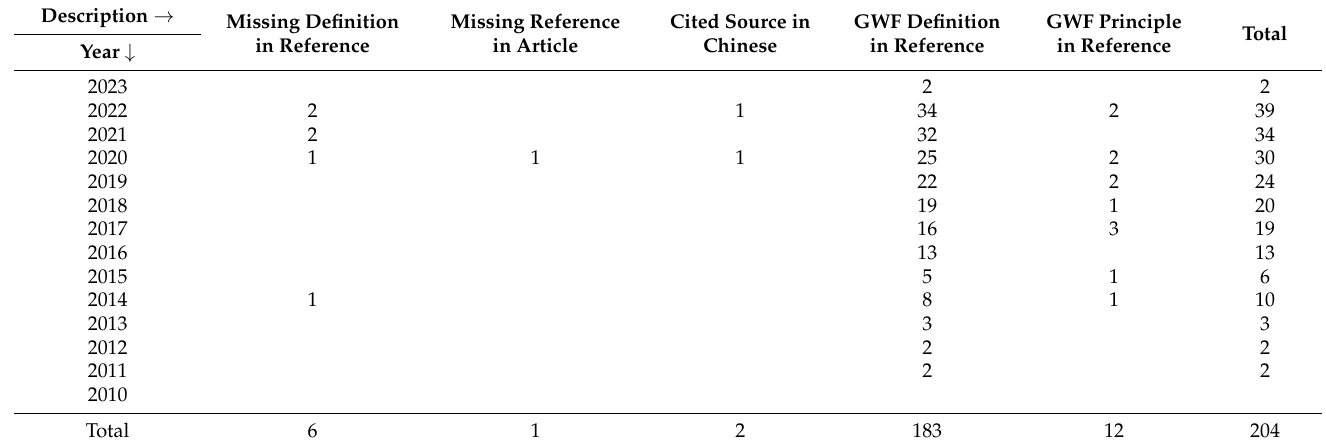
Table 1. Results of analysis of the GWF definition/GWF principle